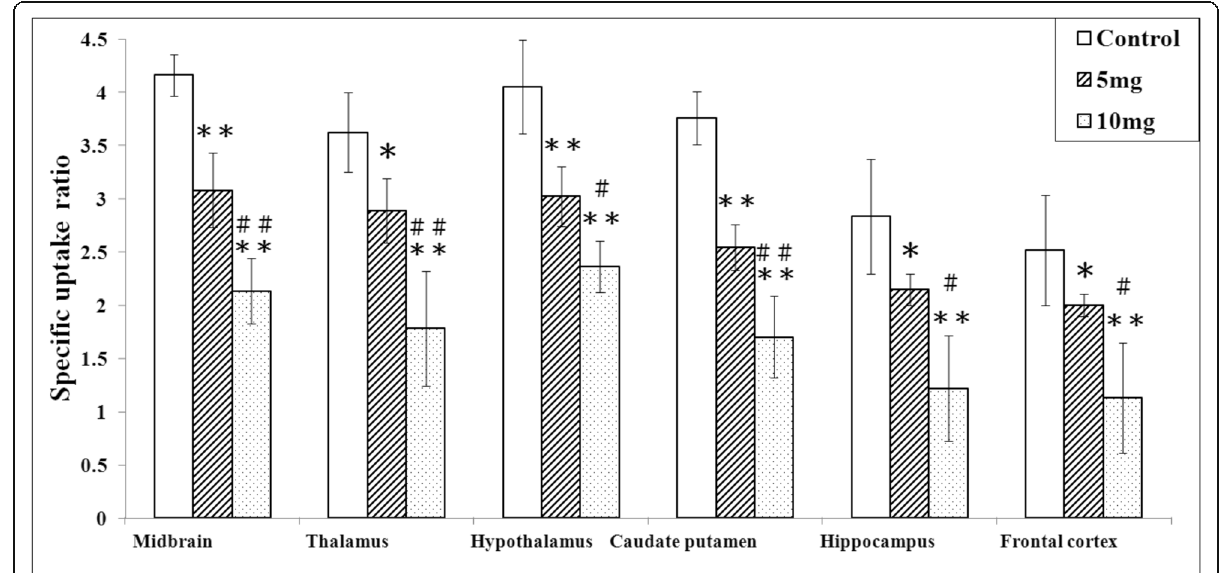
Fig. 4 The specific uptake ratios (SURs) of 4-[ 18 F]ADAM PET in various rat brain regions after repeated 5 or 10 mg/kg METH treatments. Data are expressed as the mean ± SD. * p < 0.05 and ** p < 0.01 compared to the control group; # p < 0.05 and ## p < 0.01 compared to the 5 mg/kg group; %, percentage of decrease compared to the control